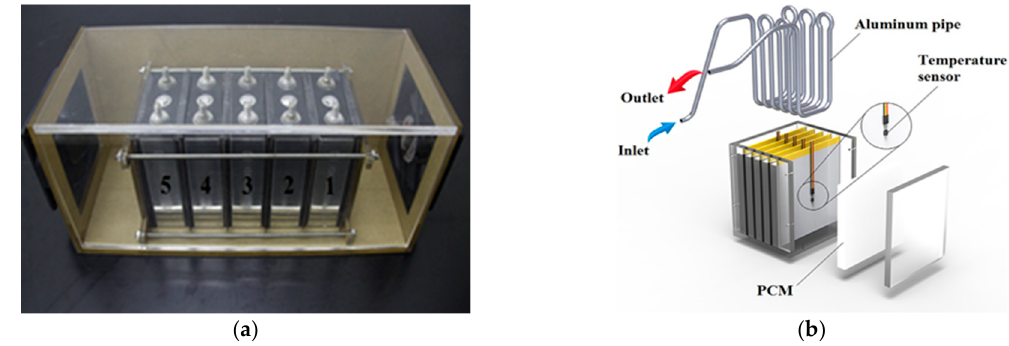
Figure 5. Examples for PCM-based hybrid BTMS ( a ) PCM+Air. Reprint with permission [57]; 2020, Elsevier., ( b ) PCM+Liquid. Reprint with permission [58]; 2020, Elsevier.